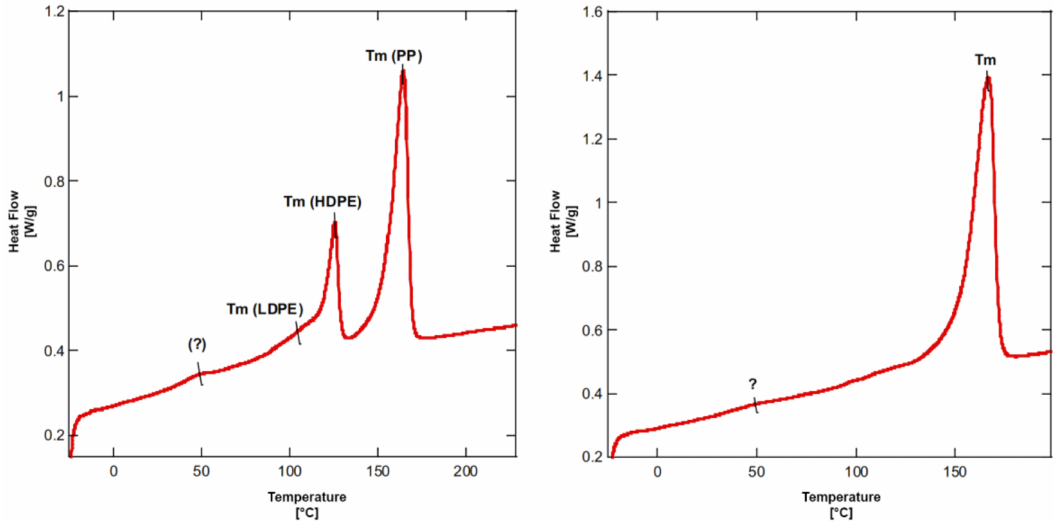
Figure 3. Thermogram of PC100-PI0 blend ( left ) and of PC0-PI100 blend ( right ) during the first heating phase. Figure 4 shows thermograms for the first heating phase of all the blends. While it is not impossible to identify a definite temperature trend depending on PC content, there may be a slight increase in PP melting temperature as PI percentage increases, but the described differences are quantitatively in the range of experimental error.